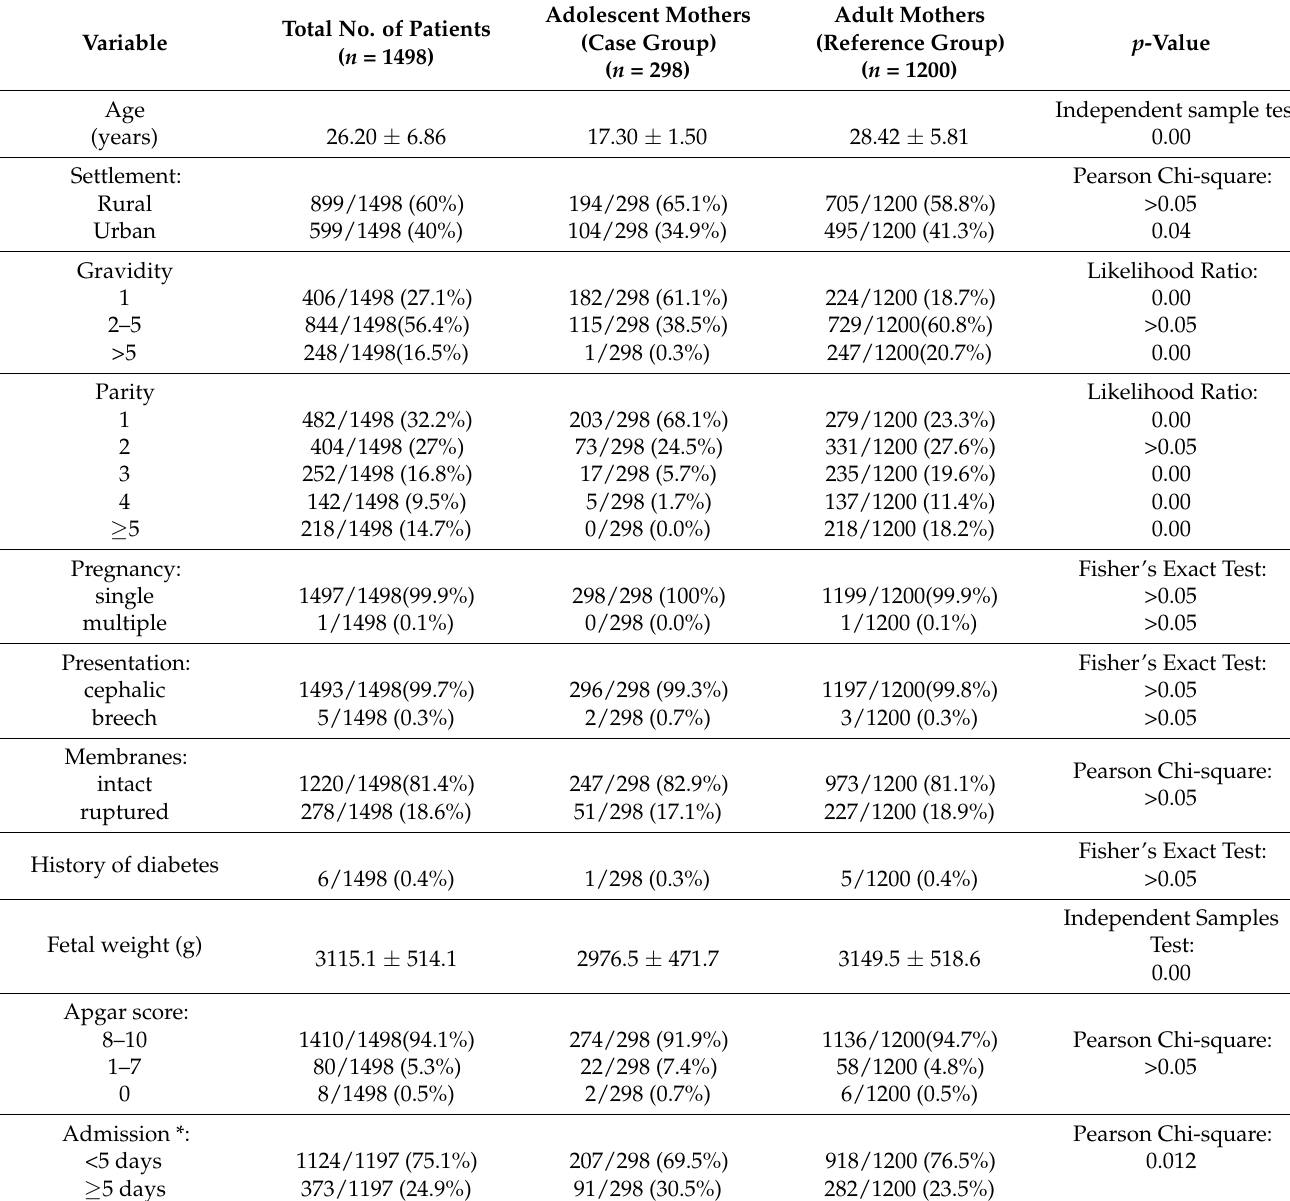
Table 1. Demographic and obstetrical characteristics of women in the study